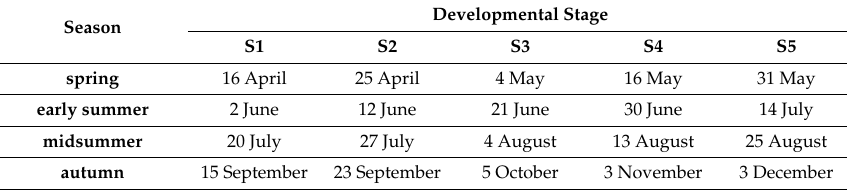
Table 1. Sampling dates for the distinct developmental stages and seasons.